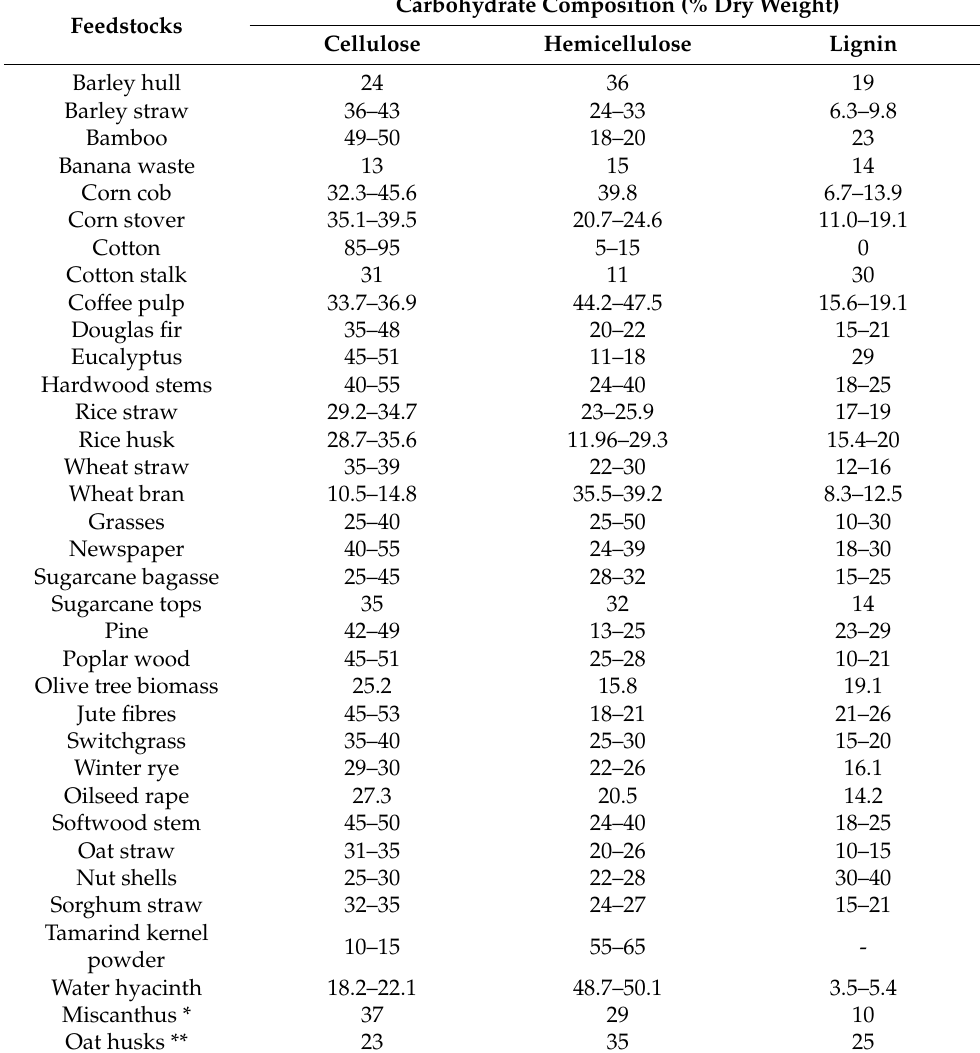
Table 1. Composition of representative lignocellulosic feedstocks